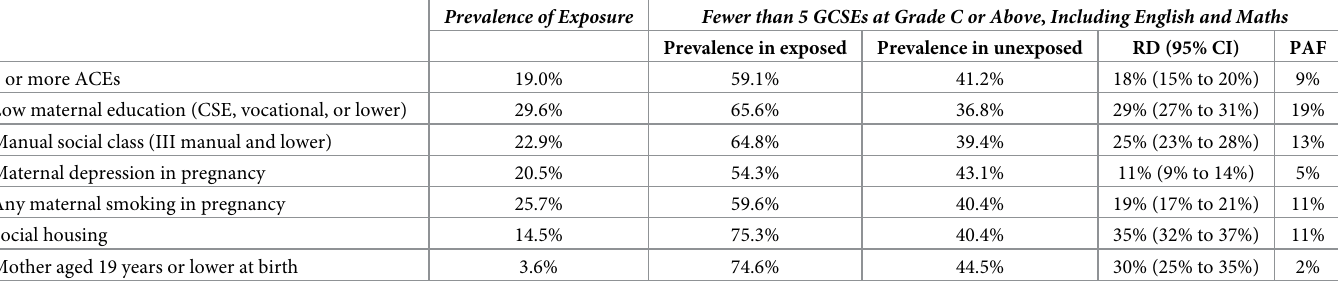
Table 2. Associations of ACEs and various sociodemographic markers with educational attainment on the RD scale and PAFs. PAF is the proportion of the people experiencing < 5 GCSEs (which are qualifications obtained at age 16, which was the end of compulsory education for this cohort) at grade C or above (including English and Maths) who also experienced the ‘exposure’ (ACE or sociodemographic variable). PAF can be interpreted as the proportion of the cases of < 5 GCSEs at grade C or above that could be prevented if the exposure was eliminated, assuming causality. Note that the reference categories in this table differ from those in other parts of the man- uscript; here, the reference category is all other participants apart from those with the exposure (for example, the reference category for 4+ ACEs here is < 4 ACEs). Prevalence of Exposure Fewer than 5 GCSEs at Grade C or Above , Including English and Maths